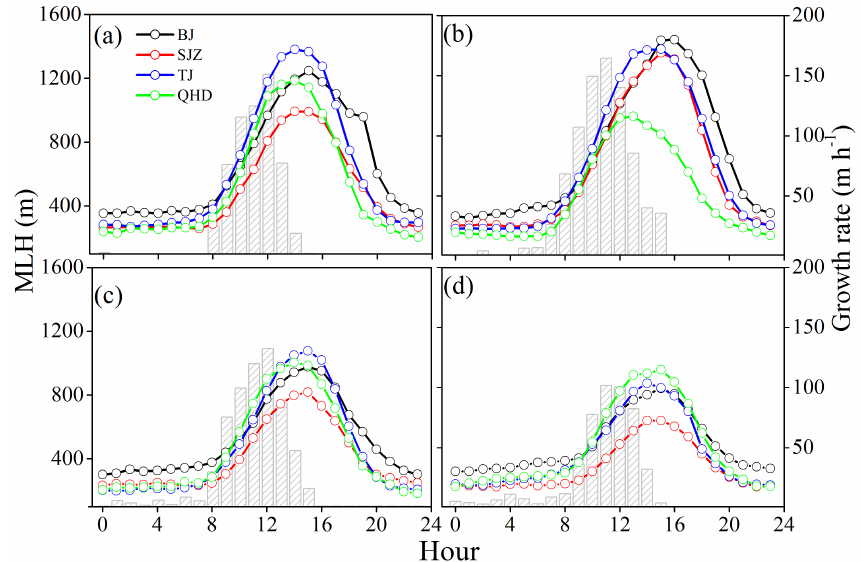
Figure 4. Diurnal variations of MLH at the BJ, SJZ, TJ and QHD stations in (a) spring, (b) summer, (c) autumn and (d) winter seasons are indicated by lines and scatters. The growth rates averaged over the four sites are drawn with gray columns for each season to represent the MLH growth velocity, and only positive values are shown in the